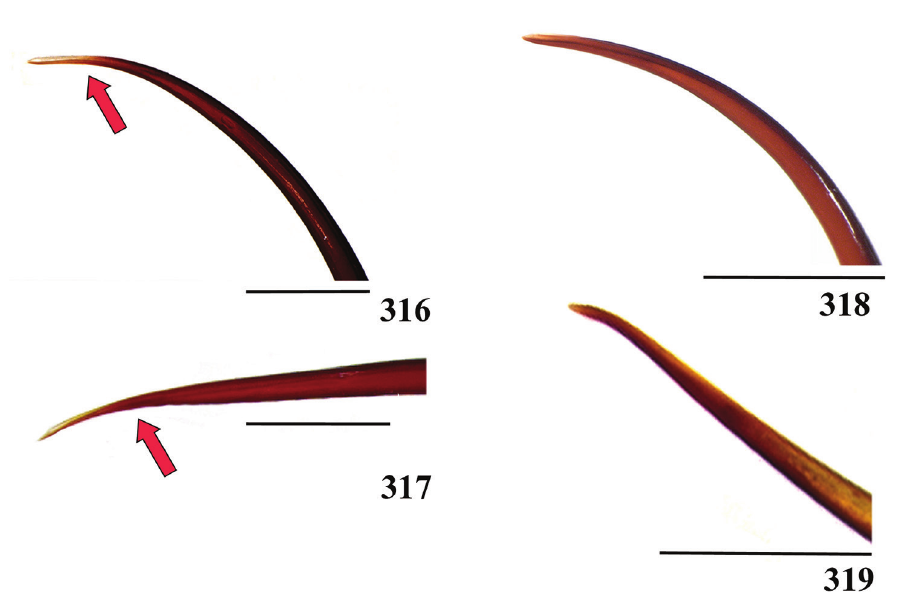
Figures 316–319. Embolus tip of male palpal bulb. 316–317 tip narrowing abruptly 316 Avicularia avicularia (MNRJ 13659A), frontal view 317 Avicularia variegata stat. n. (INPA 4897), dorsal view 318–319 tip tapering 318 Caribena versicolor comb. n. (MNHN–AR 4904), frontal view 319 Ybyrapora diversipes comb. n. (IBSP 119271), dorsal view. Scale bar = 1mm. Arrow indicates point of abrupt 0.37, 0.18, respectively. Tegulum: 1.31 long, 1.18 wide in retrolateral view. Cymbium subtriangular with subequal lobes. Cymbium with well-developed rounded process on retrolateral lobe, bearing thick setae (Fig. 289). Tibial apophysis (Figs 290–292): single branch on prolateral leg I, with well-developed base and grouped spiniform setae distally. Male metatarsus I touches retrolaterally tibial apophysis’ setae when folded. Color pattern (Fig. 294): carapace dark brown covered with abundant light brown short body setae especially on its margins. Legs, palps and chelicerae dorsally brown covered with light brown short body setae. Legs and palps with brown long guard- setae. Leg rings on distal femora, tibiae and metatarsi whitish. Abdomen dorsally dark brown with light pattern. Coxae, labium, sternum, maxillae and legs ventrally brown with light brown setae. Tibiae, metatarsi and tarsi ventrally darker. Abdomen ventral- ly greyish, distal third darker. Living specimens shows intense metallic pinkish short body setae over carapace, dorsal legs and palps. Abdomen is dorsally black with lighter leaf pattern. Color pattern ontogeny. See Bertani and Huff (2013) (Fig. 293). Distribution. Dominican Republic (Fig. 226). Natural history. See Bertani and Huff (2013).